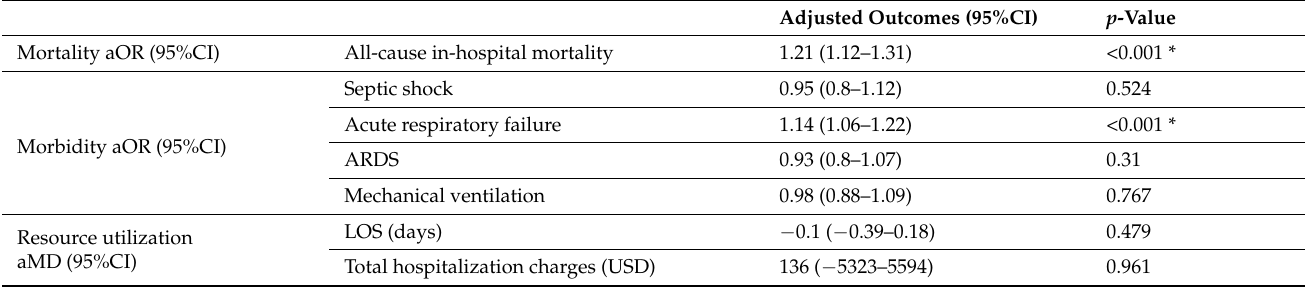
Table 3. Outcomes of the multivariate regression adjusted